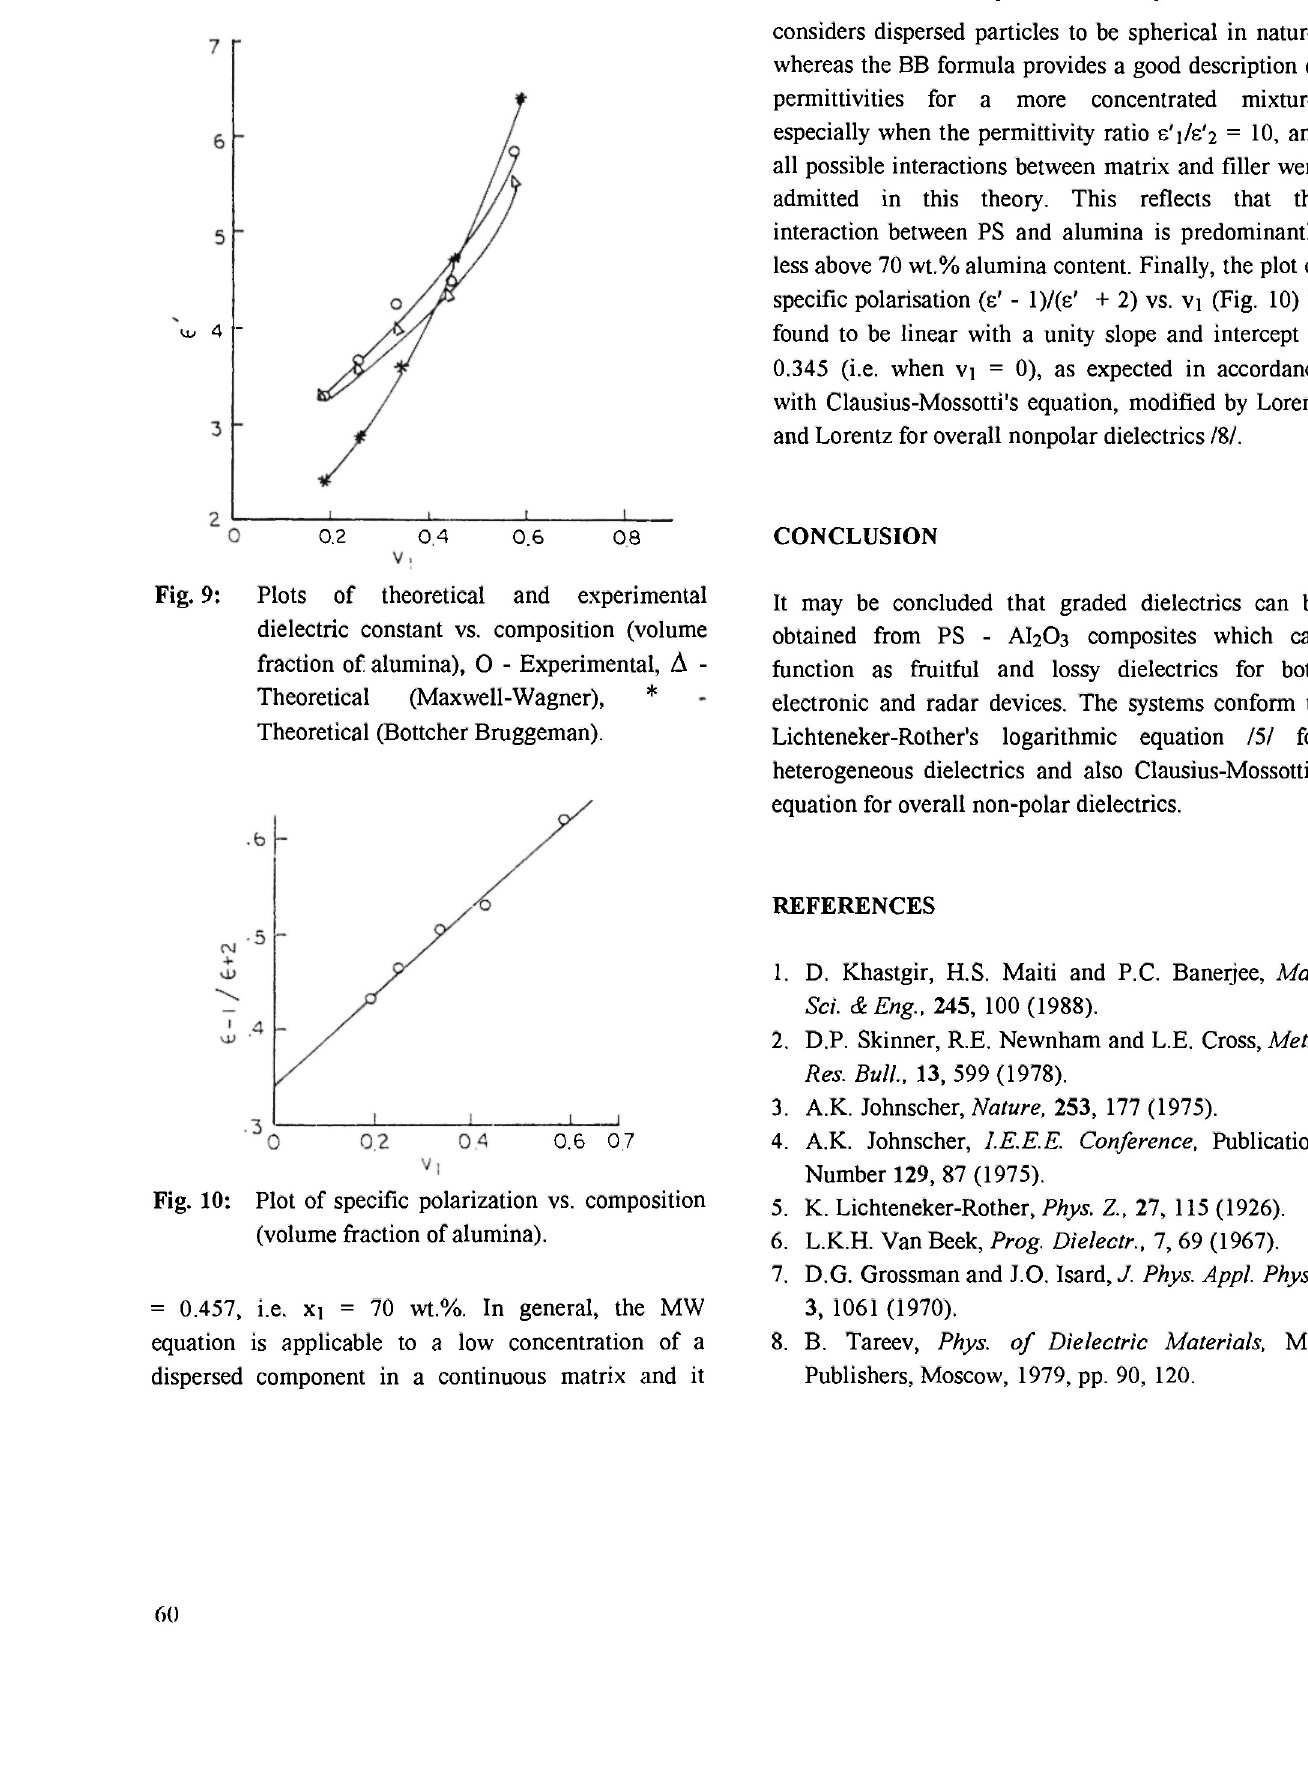
08 Fig. 9: Plots of theoretical and experimental dielectric constant vs. composition (volume fraction of alumina), Ο - Experimental, Δ - Theoretical (Maxwell-Wagner), * Theoretical (Böttcher Bruggeman).